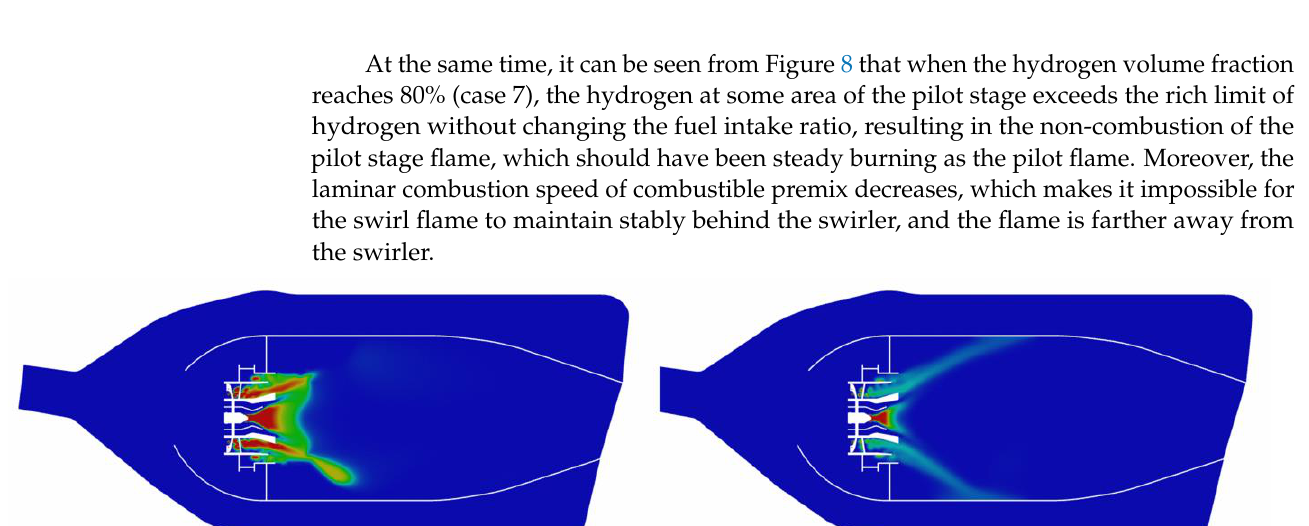
Table 3. The fuel residue at the combustor outlet under constant fuel mass flow rate.